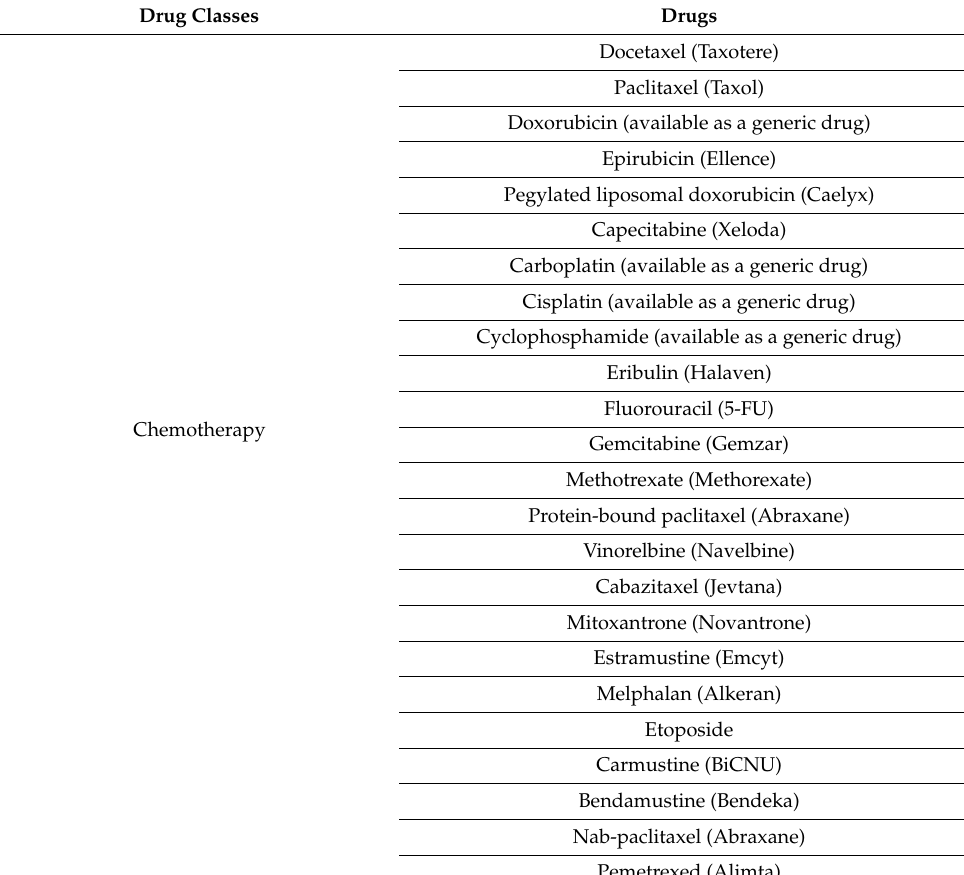
Table A1. Classification of identified